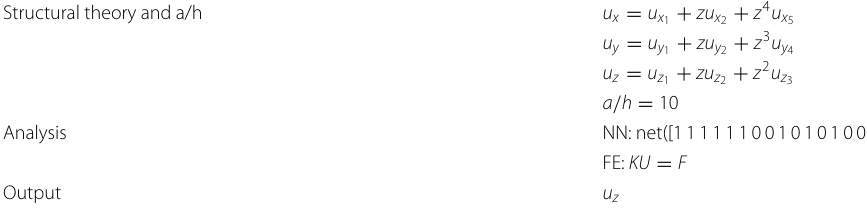
Table 2 Overciew of computational costs Process Analyses Cost BTD via FE 32768 linear static analyses Data training generation Training of NN Table 3 Comparison between NN and FE Structural theory and a/h